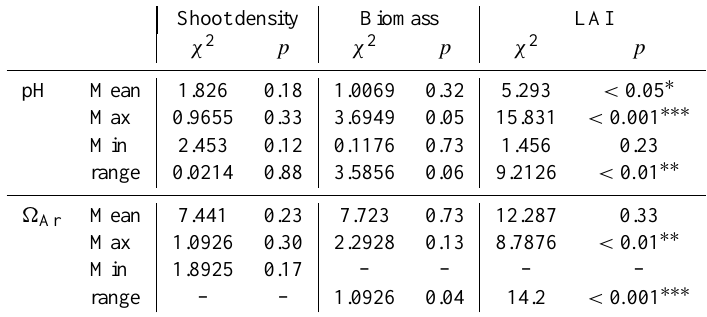
Table 3. Results from Generalized Linear Mixed Models (lme4 package in R) with Gaussian distribution, and link identity with site as a random effect (repeated measures) testing the effect of structural parameters on the mean, max, min and range of pH and (cid:127) Ar . Where no results are given the no-slope model explained more variation.